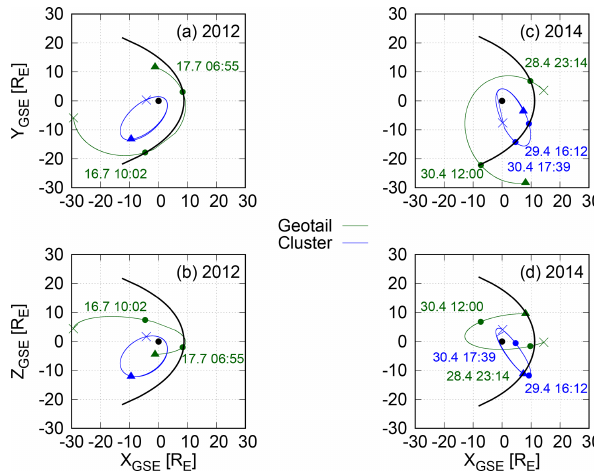
Figure 3. Orbits of Cluster 1 (blue) and Geotail (green) satellites during 14 July 09:00UT–17 July 15:00UT, 2012 (a, b) and during 28 April 19:00UT–1 May 17:00UT, 2014 (c, d) . Orbits are shown on the XY plane in panels (a) and (c) and on the XZ plane in pan- els (b) and (d) . The coordinate system is GSE. The most earth- ward position of the Shue magnetopause during both time inter- vals is drawn in black. Start and end points of the time intervals are marked with a cross and a triangle, respectively. The points along the satellite orbits between which the spacecraft may encounter magnetopause crossings are marked with